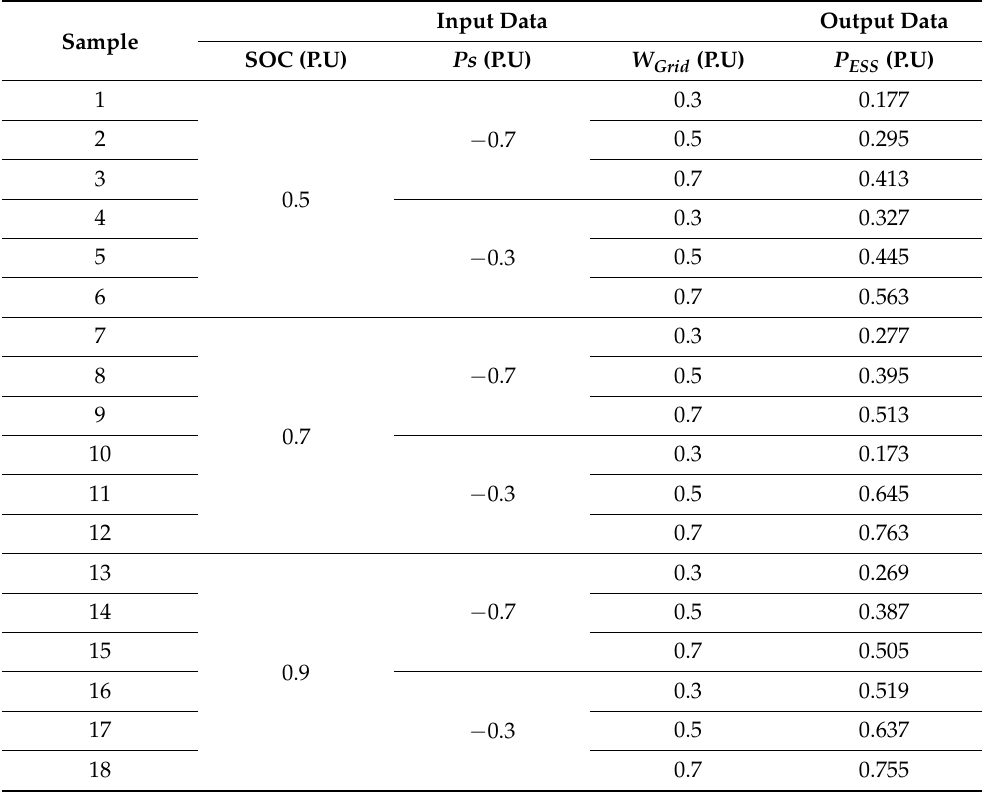
Table 3. ANN training data of mode 3.